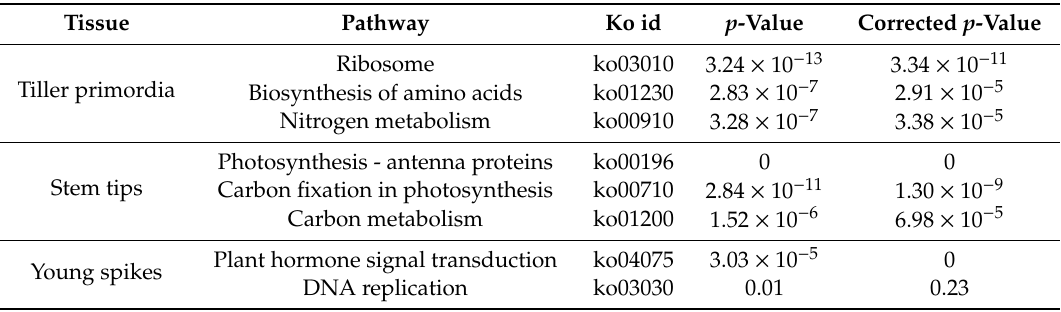
Table 1. The major pathways in the three tissues referring to Kyoto Encyclopedia of Genes and Genomes (KEGG) database. Tissue Pathway Tiller